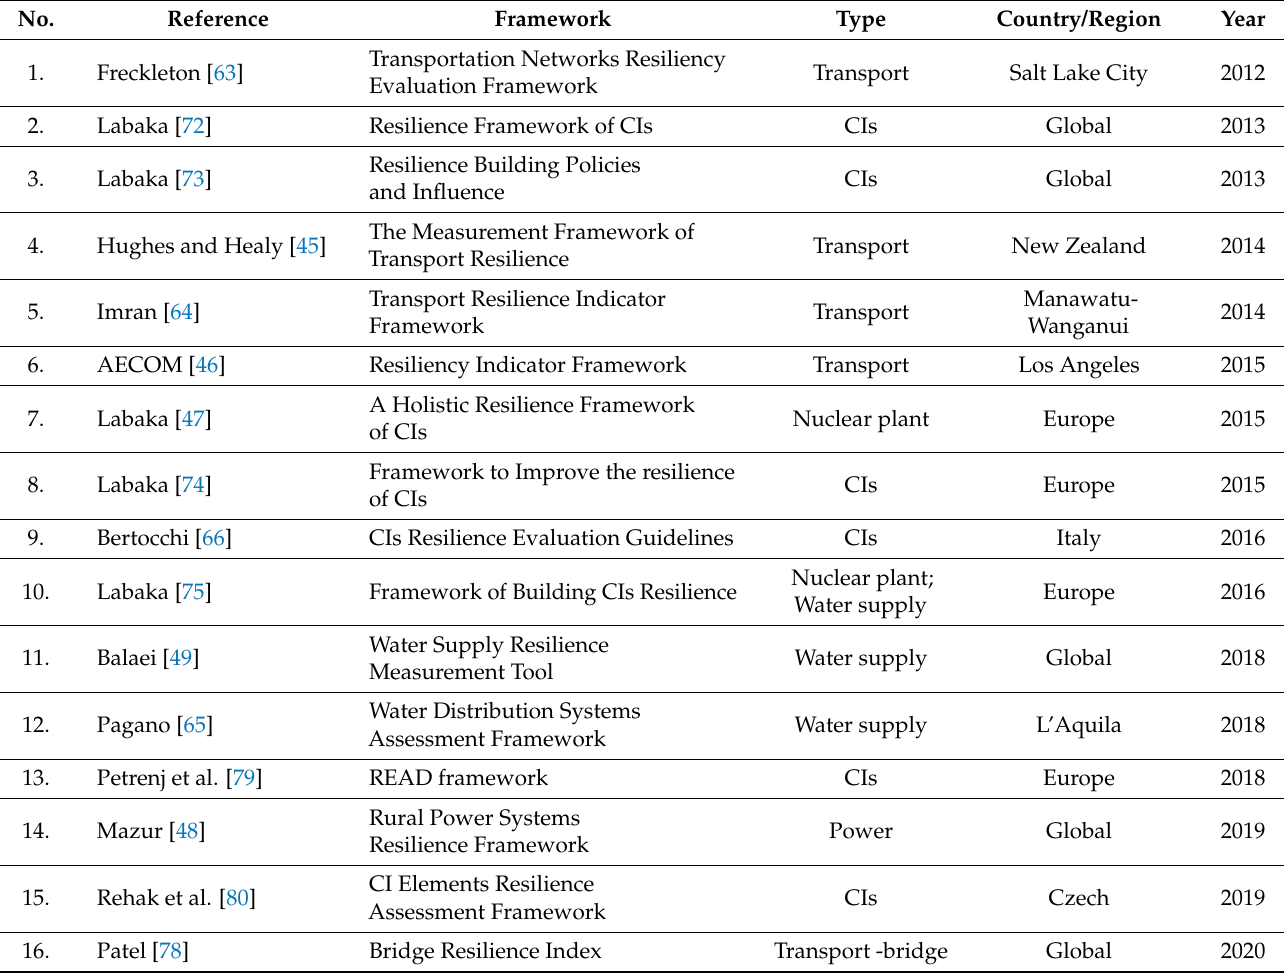
Table 1. Basic information of identified resilience assessment frameworks of CI for